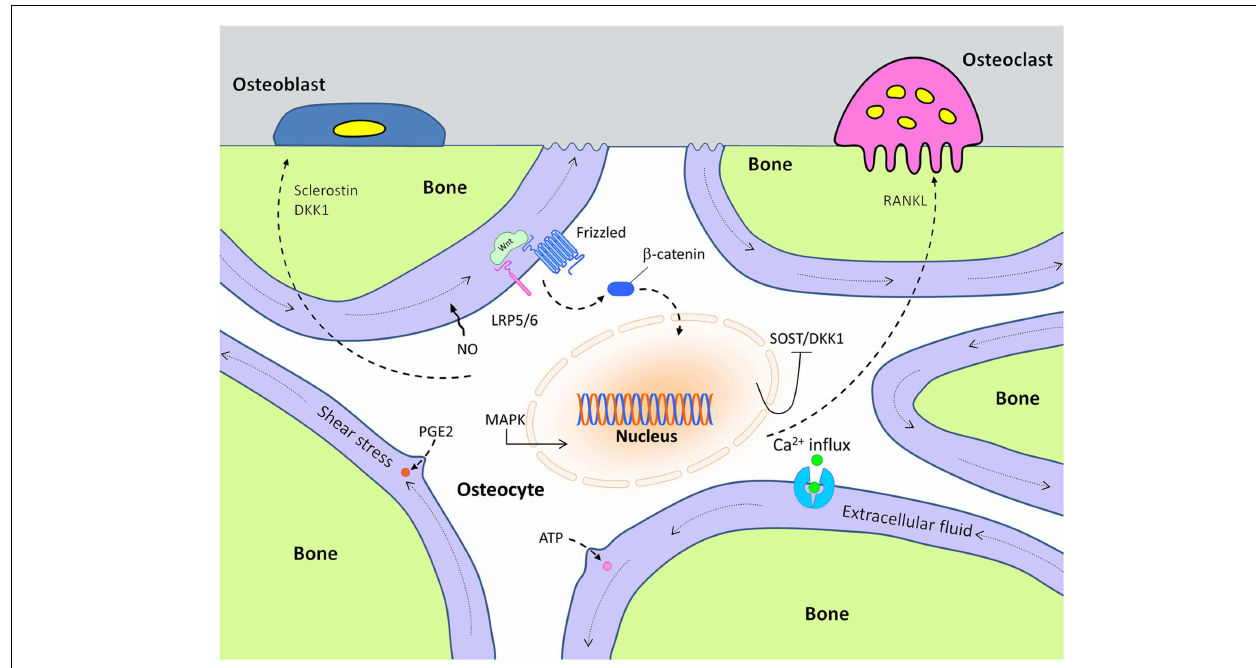
FIGURE 1 | Cellular mechanisms of action in mechanically stimulated osteocytes, which control osteoblast and osteoclast activity .